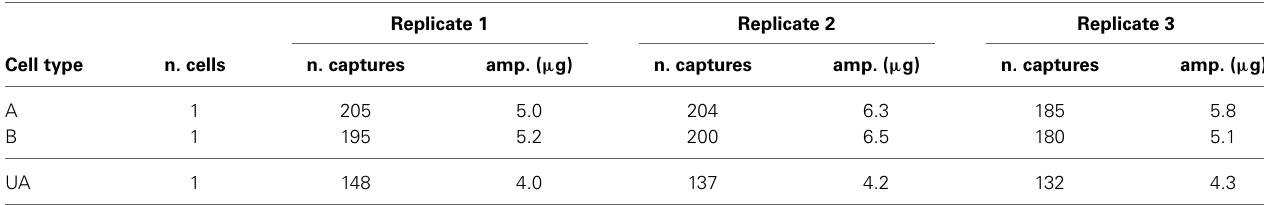
Table 2 | Number of captures and final quantity of amplified cDNA per cell type and per biological